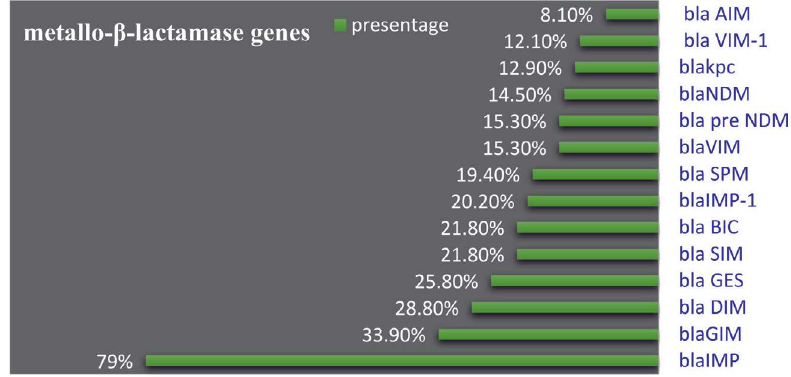
Fig. 4. distributing Metallo- β -lactamase genes among A.baumannii